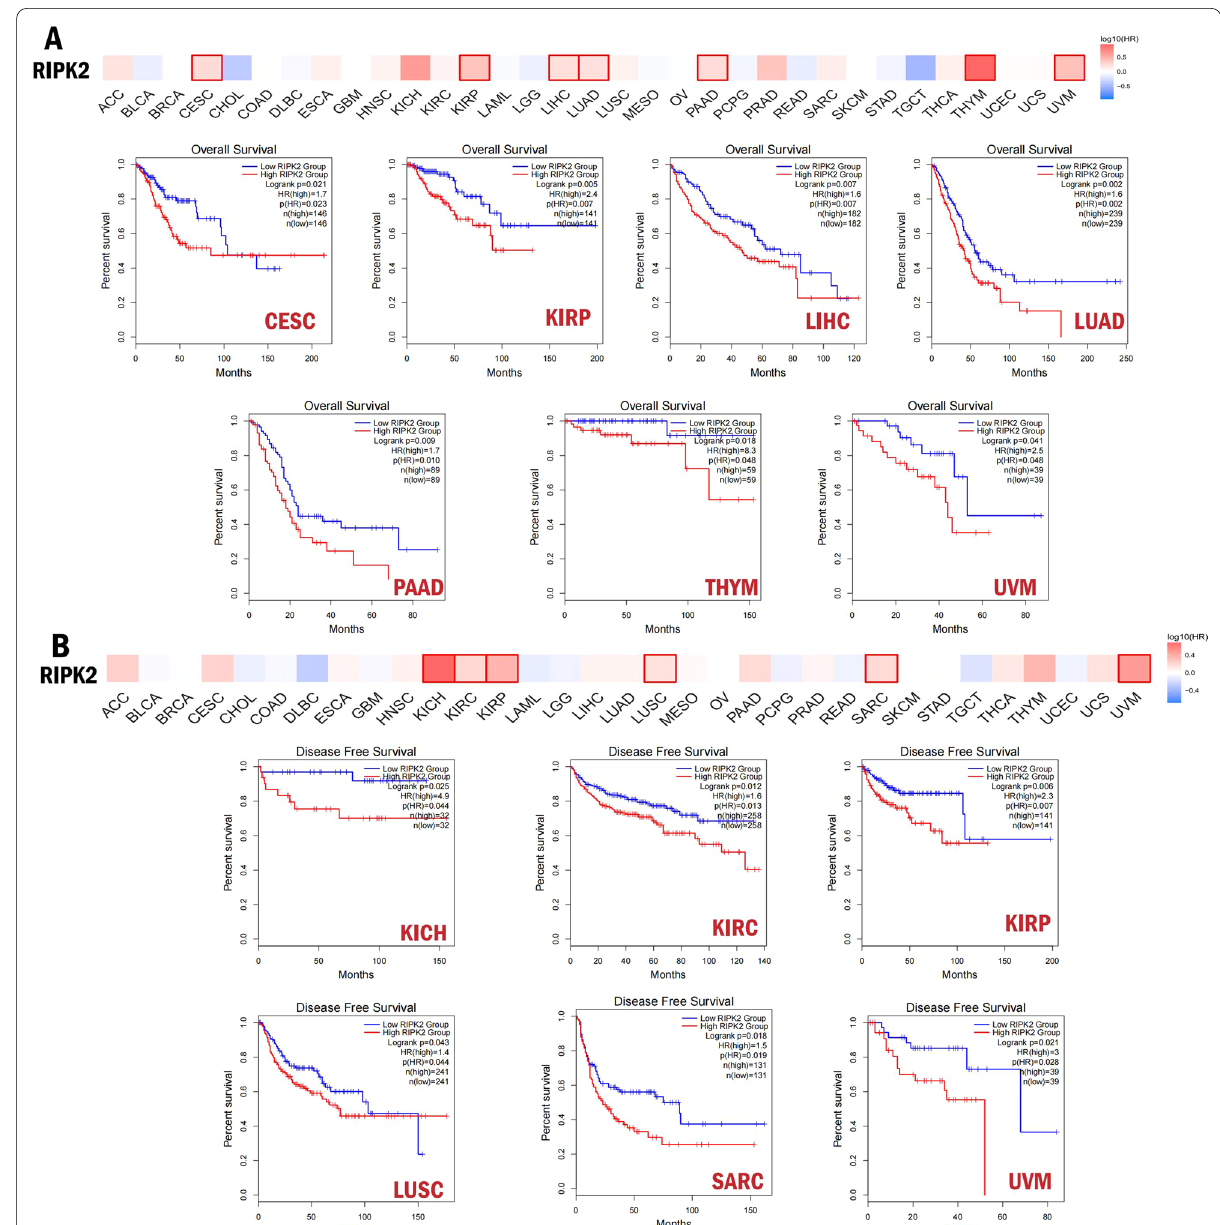
Fig. 2 Correlation between RIPK2 expression and overall survival and disease-free survival of patients in different kinds of tumor. A Survival map (OS) from the online tool GEPIA2 (upper panel). Kaplan–Meier survival plots (OS) comparing high and low expression of RIPK2 in different kinds of cancer (CESC, KIRP, LIHC, LUAD, PAAD, THYM, UVM) (lower panel). B Survival map (DFS) from the online tool GEPIA (upper panel). Kaplan–Meier survival plots (DFS) comparing high and low expression of RIPK2 in different kinds of cancer (KICH, KIRC, KIRP, LUSC, SARC, UVM) (lower